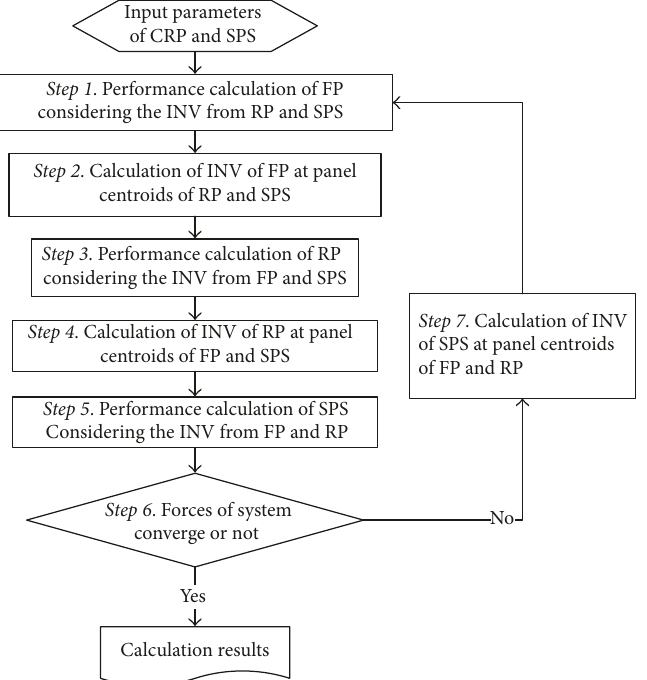
Figure 13: Iteration flow diagram of FPF calculations of CRP. INV is the abbreviation of induced velocities. FP and RP represent the forward and rear propellers, and SPS denotes the spherical